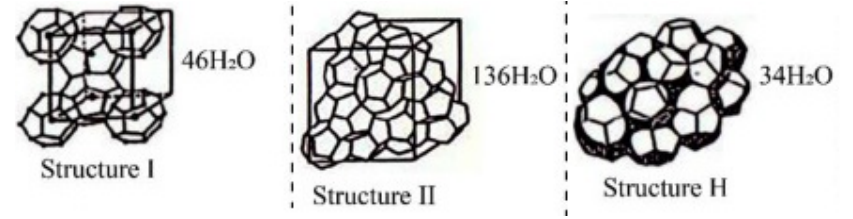
Figure 1. Gas hydrates’ common structures.